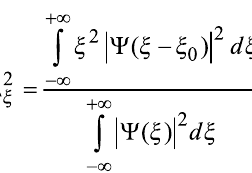
As expected from the uncertainty principle, Δ s,t Δ s , ω =